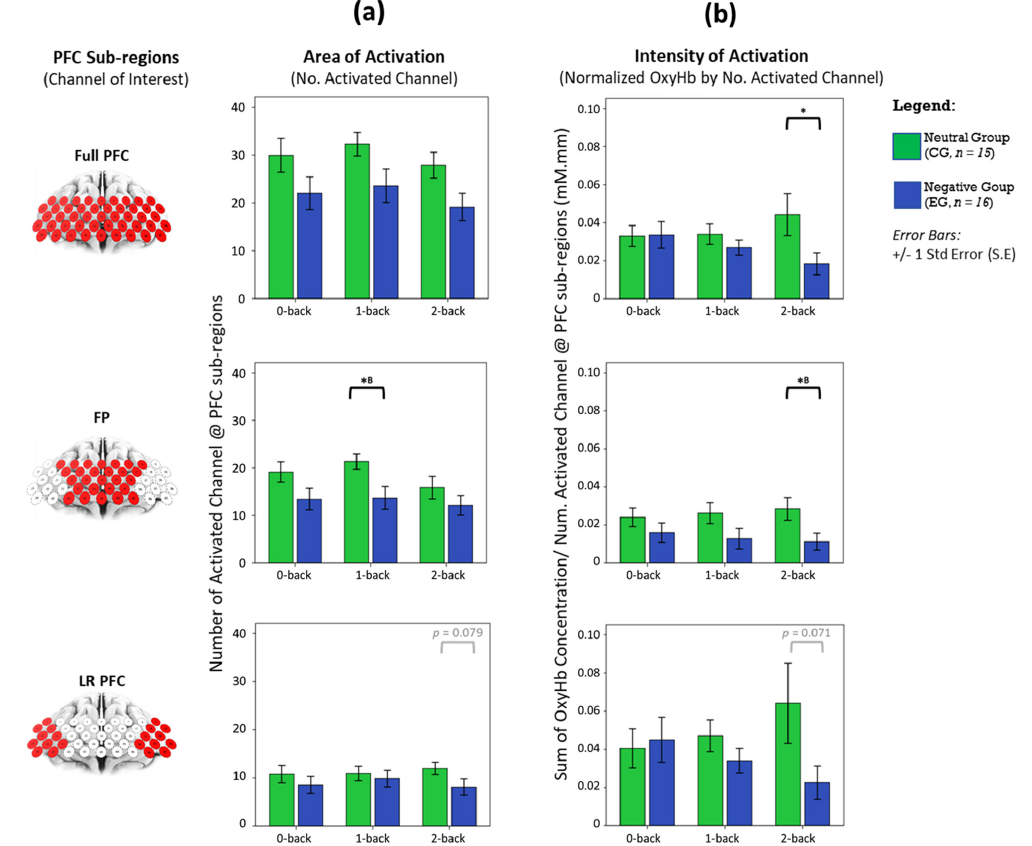
Figure 3. Does haeomodynamic activity vary due to changes in area of activation or strength, and are there any dominant effects neuroanatomically? We plotted ( a ) the number of significantly activated channels and ( b ) normalised activation from significantly activated channels against WML and affective states in whole PFC, FP and LRPFC regions. Statistical analysis performed between CG and EG using an independent t -test (2-tailed), with significant * p < 0.05 without family-wise error rate correction and ( B ) with Bonferroni–Holm’s correction ( α = 0.0167). Error bars indicate the standard error (S.E).